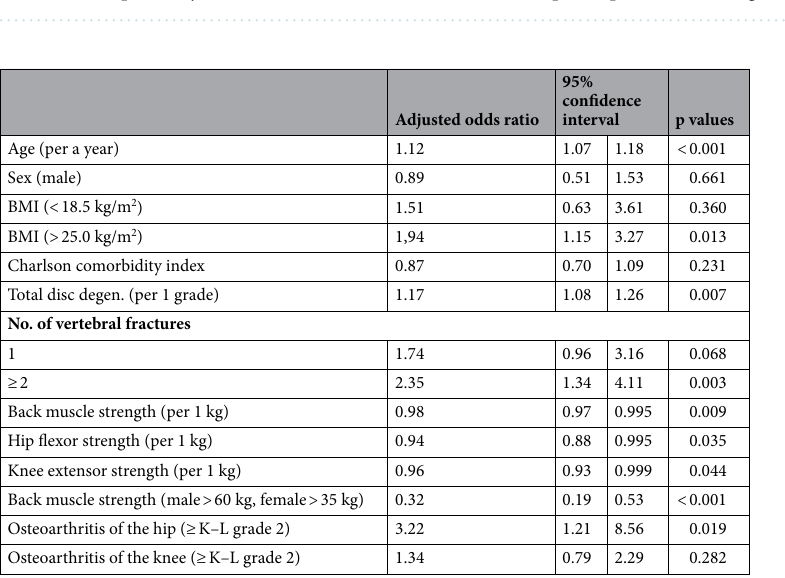
Figure 1. The receiver operating characteristic (ROC) curve was used to investigate the relationship of back muscle strength with sagittal malalignment (sagittal vertical axis [SVA] > 95 mm). Two methods to estimate Youden’s index (Y) and the distance from the top left corner of the receiver operating characteristic curve (D) were used to determine the cut-off value. The areas under the curve for male and female participants were 0.873 and 0.807, respectively. The cut-off values for male and female participants were 60 kg and 35 kg, respectively.